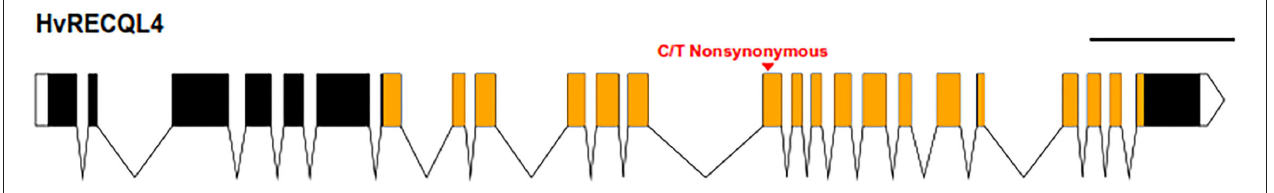
FIGURE 1 | Graphical representation of HvRECQl4 . The 24 exons are represented by the boxes joined by the introns with untranslated regions (UTRs) unfilled and the conserved helicase domain in orange. The position of the mutation is marked by the red arrow. Scale bar: 1kb. Diagram produced with the exon-intron graphic maker (wormweb.org/exonintron).